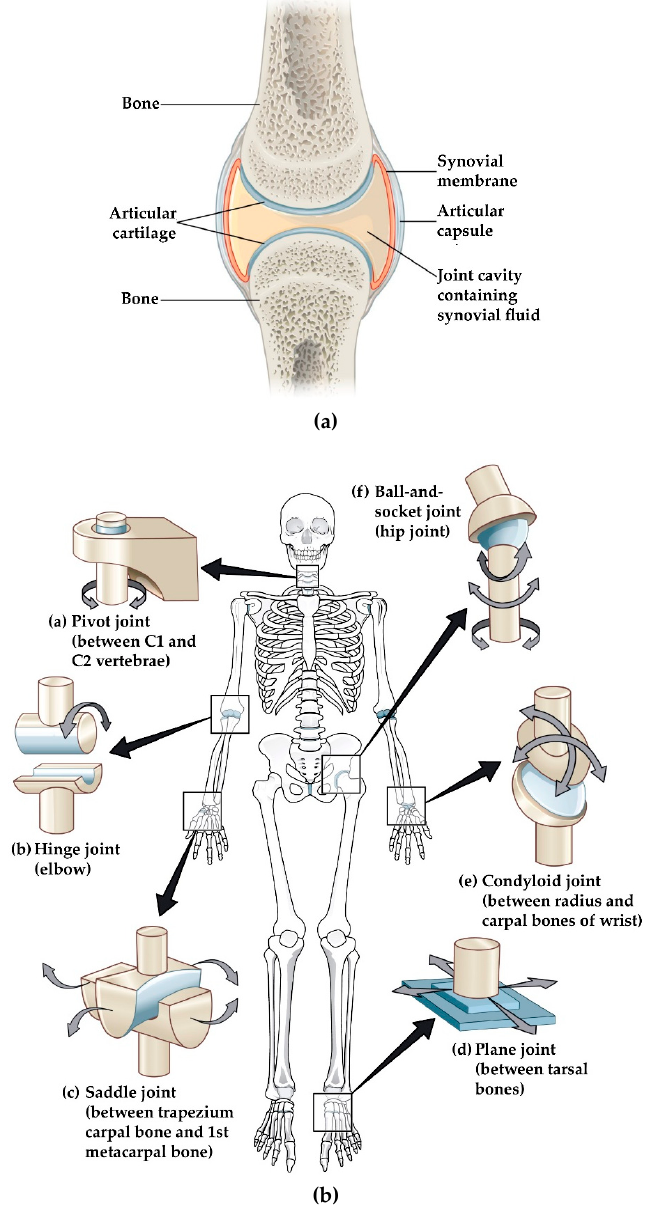
Figure 1. ( a ) Synovial joints; ( b ) Types of synovial joints. Image source: